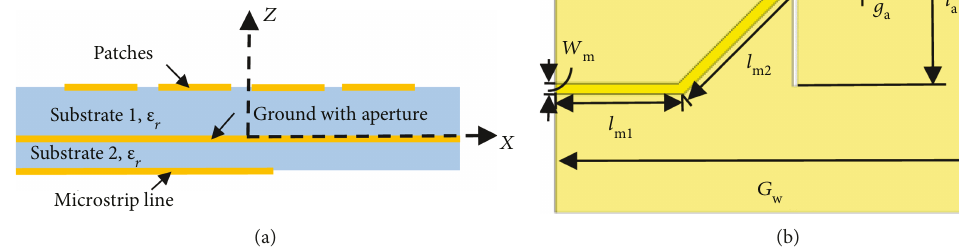
Figure 7: A CP monopole antenna with H-shaped cells on the fi rst substrate